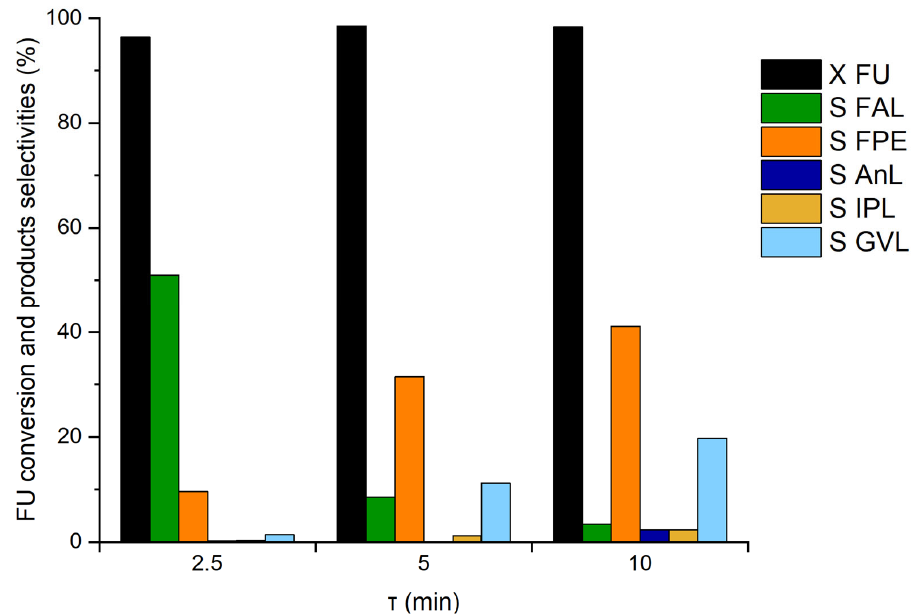
Figure 10. Furfural conversion and product selectivity trends as a function of contact time (min) using Ti/Zr/O (1:1). Reaction conditions: [FU] = 67 mM, T = 180 °C, m cat = 0.76.